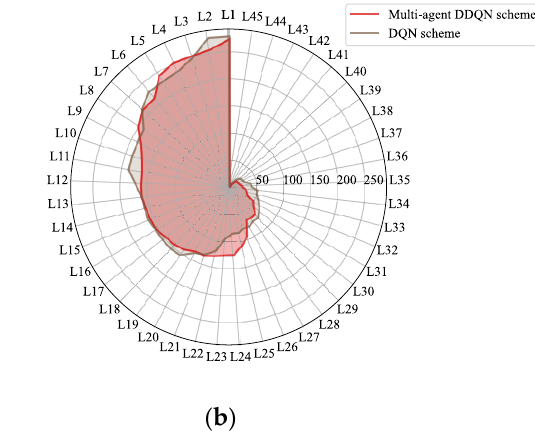
Figure 10. ( a ) Comparison of line power flow distribution between the initial power flow and the scheme obtained by multi-agent DDQN. ( b ) Comparison of line power flow distribution between the schemes obtained by DQN and the multi-agent DDQN.